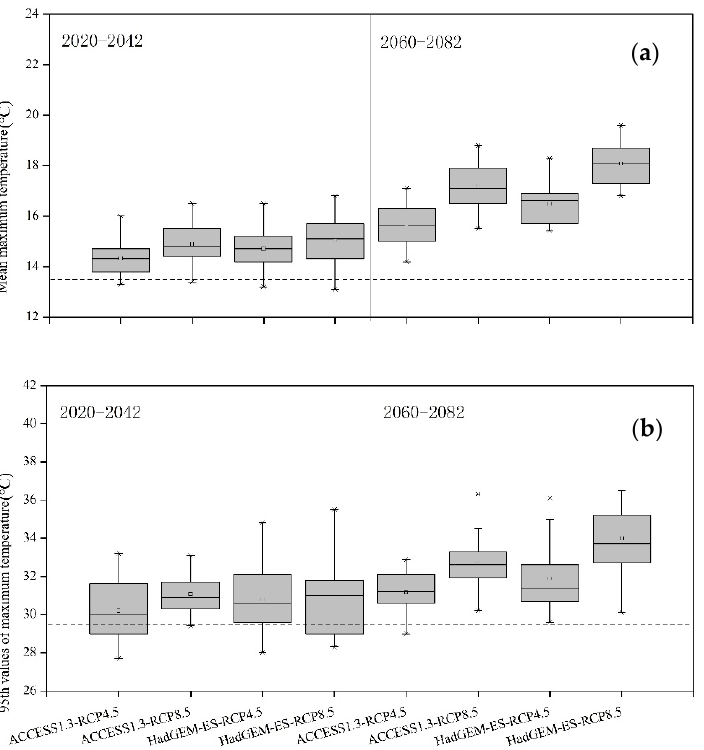
Figure 3. ( a ) Projected mean and ( b ) 95th values of maximum temperature under the different combinations of General Circulation Models (GCMs) and Representative Concentration Pathways (RCPs) scenarios during the different assessment periods.